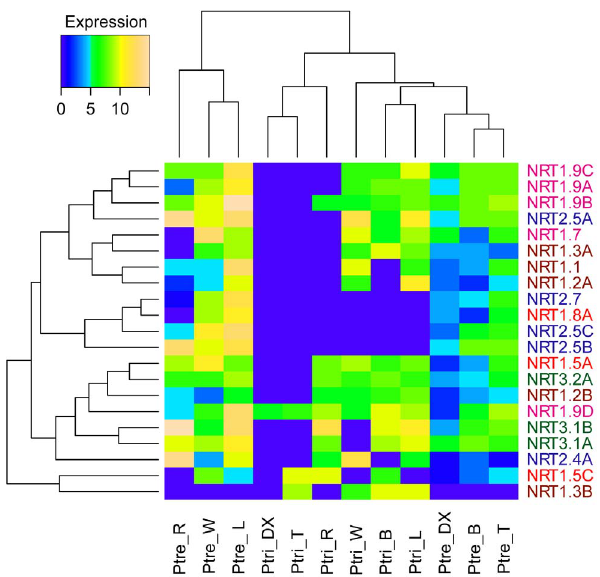
Figure 4. Comparison of tissue-specific expression patterns of NRT genes in P. trichocarpa (Ptri) and P. tremula (Ptre). The heatmap represents the hierarchical clustering of average log 2 (relative expression) of NRT genes in stem top (T), bark (B), developing xylem (DX), leaves (L), wood (W), and roots (R). The color of the gene name represents the clade in the phylogenetic tree (Figure